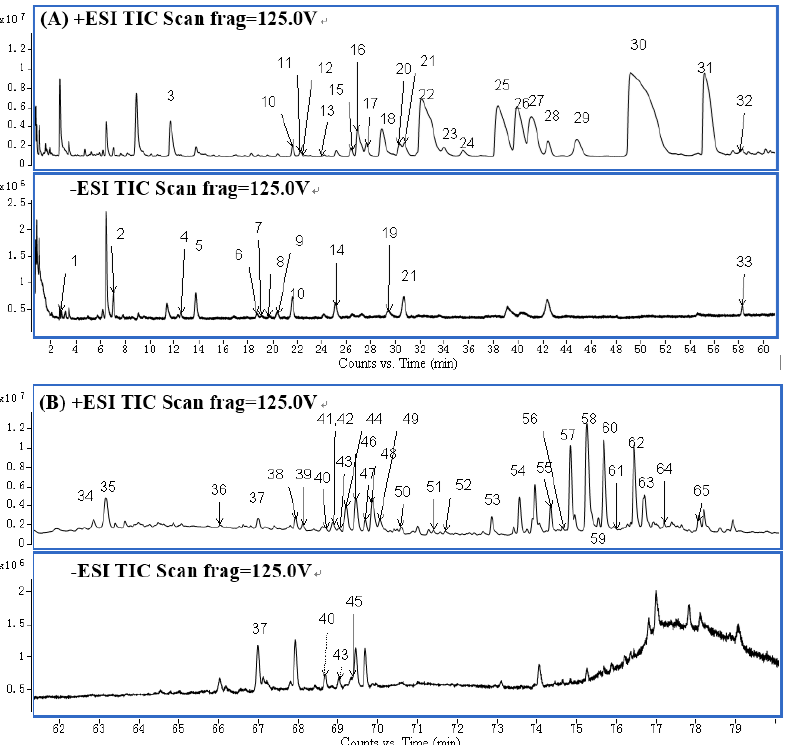
Figure 1. TIC of the CR-EF herbal pair extract of 0–60 min ( A ) and 60–80 min ( B ). Peaks have been numbered according to the Table S1.